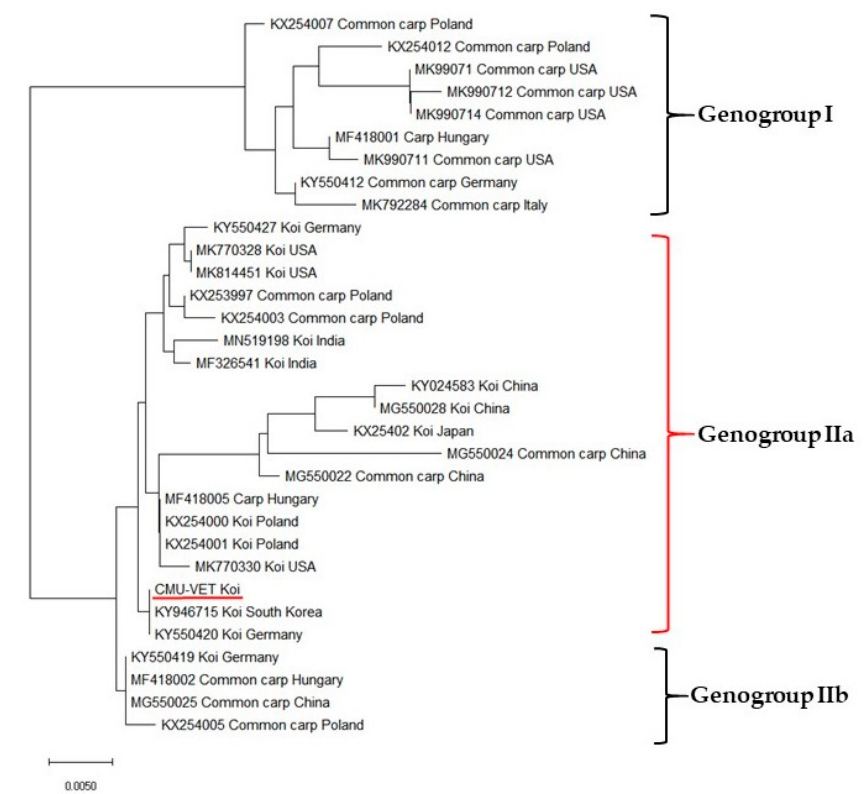
Figure 6. Phylogenetic tree based on a 478 bp partial 4a gene sequence of CEV and inferred by the neighbor-joining method using Mega X version 10.1. This analysis shows the sequences obtained from the infected koi from Chiang Mai, Thailand: CMU-VET koi, belong to genogroup IIa. The isolate fragment sequences shared 99.8 % nucleotide identity to the South Korea (KY946715) and Germany (KY550420). The scale bar represents substitutions per nucleotide